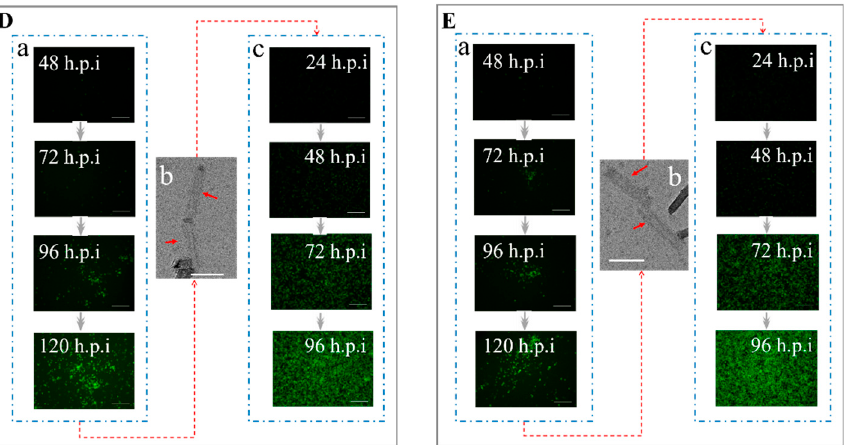
Figure 4. Construction of AcBVs with firefly luciferase expression mediated by five different promoters. ( A ) Construction of recombinant AcBV- ∆ gp64-p10-Fluc-p64-Rluc-p64-gfp-ires-gp64. ( a ) The recombinant rBacmid- ∆ gp64-p10-Fluc-p64-Rluc-p64-gfp-ires-gp64 was used to invade Sf9 cells (48–120 h, Bar = 200 µ m). ( b ) Supernatant of Sf9 cells was collected and purified by centrifugation, and the progeny AcBV- ∆ gp64-p10-Fluc-p64-Rluc-p64-gfp-ires-gp64 was observed by TEM (Bar = 200 nm). ( c ) The AcBV- ∆ gp64-p10-Fluc-p64-Rluc-p64-gfp-ires-gp64 in the supernatant was used to re-infect Sf9 cells to complete the replication of the baculovirus (24–96 h, Bar = 200 µ m). Similarly, ( B – E ) indicates construction of recombinant baculovirus AcBV- ∆ gp64-pvp39-Fluc-p64-Rluc-p64-gfp-ires-gp64 ( B ), AcBV- ∆ gp64-pcmv-Fluc-p64-Rluc-p64-gfp-ires-gp64 ( C ), AcBV- ∆ gp64-pie1-Fluc-p64-Rluc-p64-gfp- ires-gp64 ( D ), and AcBV- ∆ gp64-psv40-Fluc-p64-Rluc-p64-gfp-ires-gp64 ( E ),